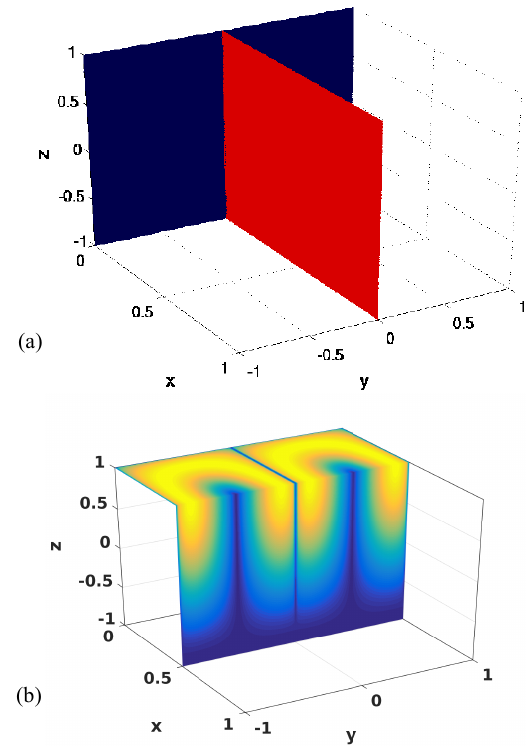
Figure 1. (a) Stable (blue) and unstable (red) manifolds of the nor- mally hyperbolic invariant curve in Eq. (2); (b) representation of the Lagrangian structures at specific slices by means of the M